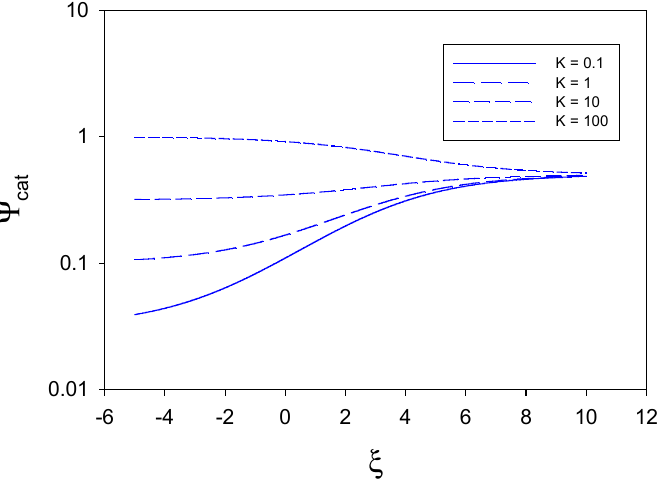
Figure 2. Variation of catalytic efficiency with normalized potential for heterogeneous redox catalysis via the bimolecular mechanism for the case of slow generation of mediator species and slow heterogeneous kinetics.